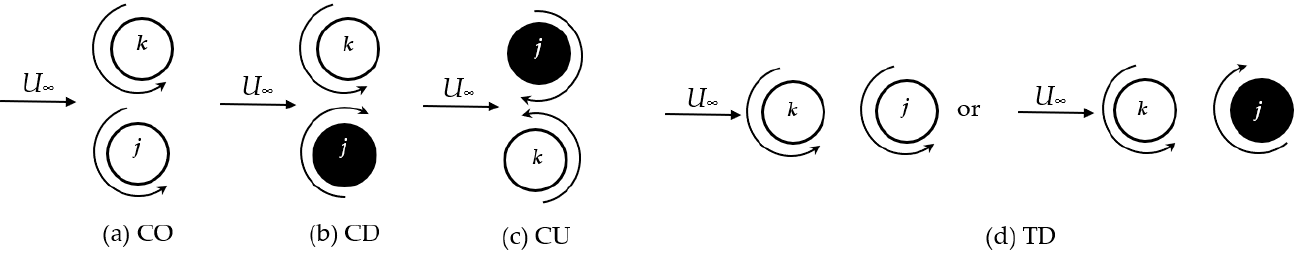
Figure 3. Four categories of the layouts between the selected two rotors: ( a ) co-rotating (CO); ( b ) counter-down (CD); ( c ) counter-up (CU); ( d ) tandem (TD).